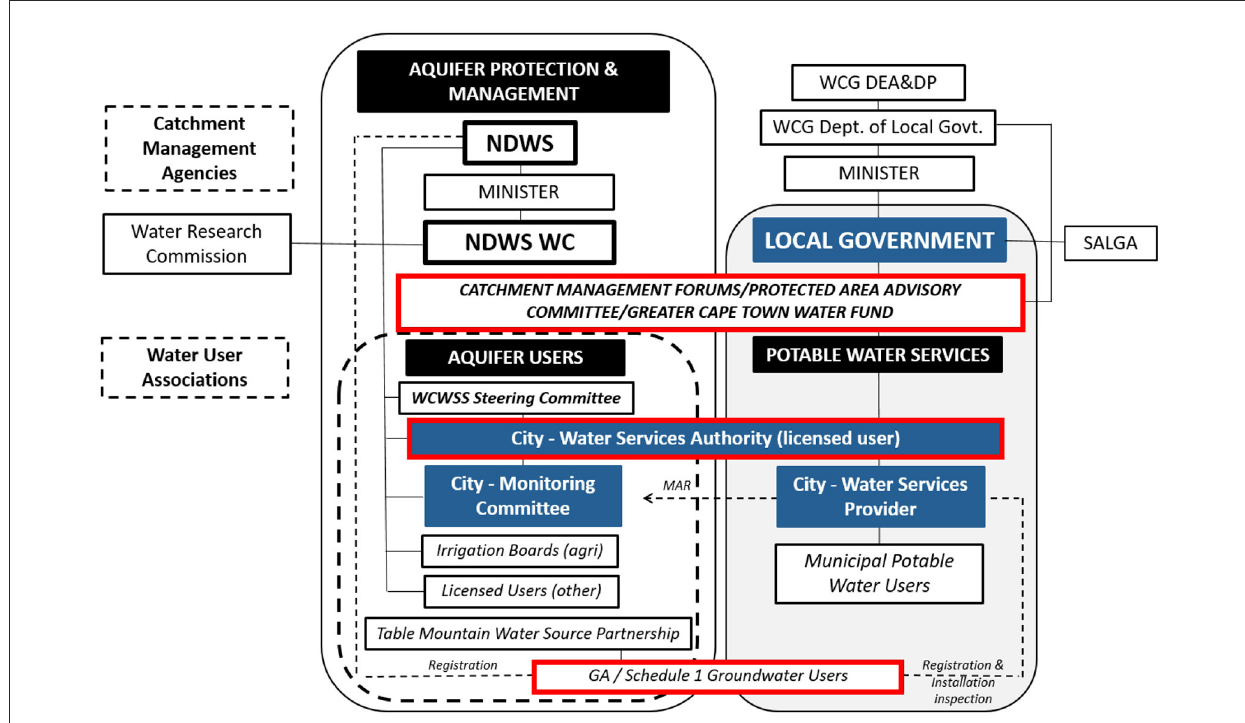
FIGURE4 Water Management Institutional Status Quo for Cape Town illustrating overlaps between aquifer protection and management, aquifer users and potable water services; Source: Faragher (2022). Dept. of COGTA refers to the Department of Cooperative Governance and Traditional Affairs.